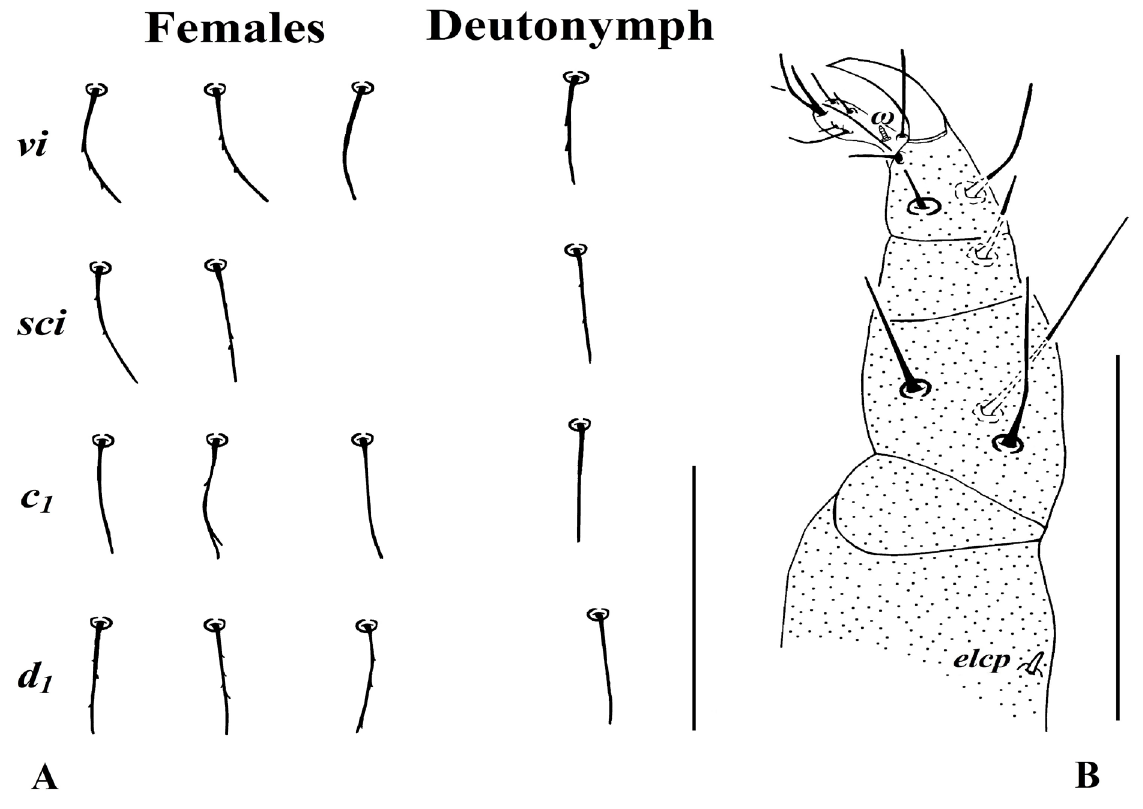
Fig. 5. Stigmaeus miandoabiensis Bagheri & Zarei, 2012. A . Some dorsal body setae. B . Palp (♀). Scale bars = 40